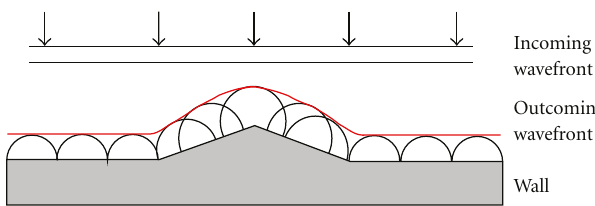
Figure 7: Di ff usion phenomenon: a planar wavefront falls onto a rough surface from a perpendicular direction. The wavefront that bounces o ff the surface, resulting from a combination of secondary wavefronts, will not propagate just in the specular direction with respect to the exciting